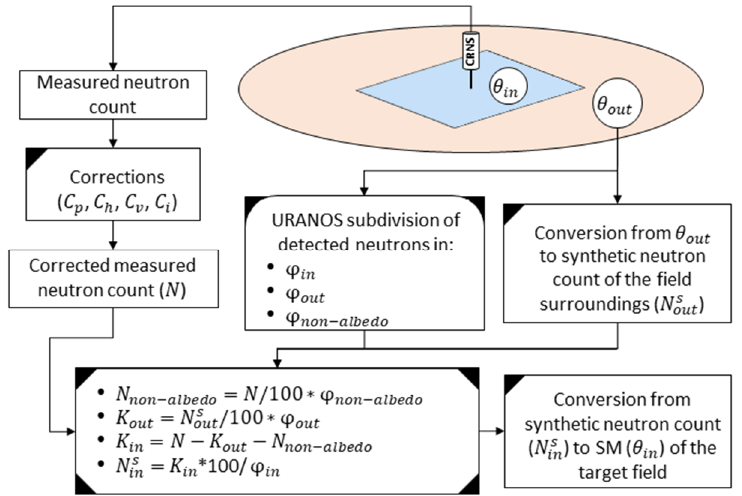
Figure 2. Flowchart of the proposed CRNS correction method to obtain θ in .